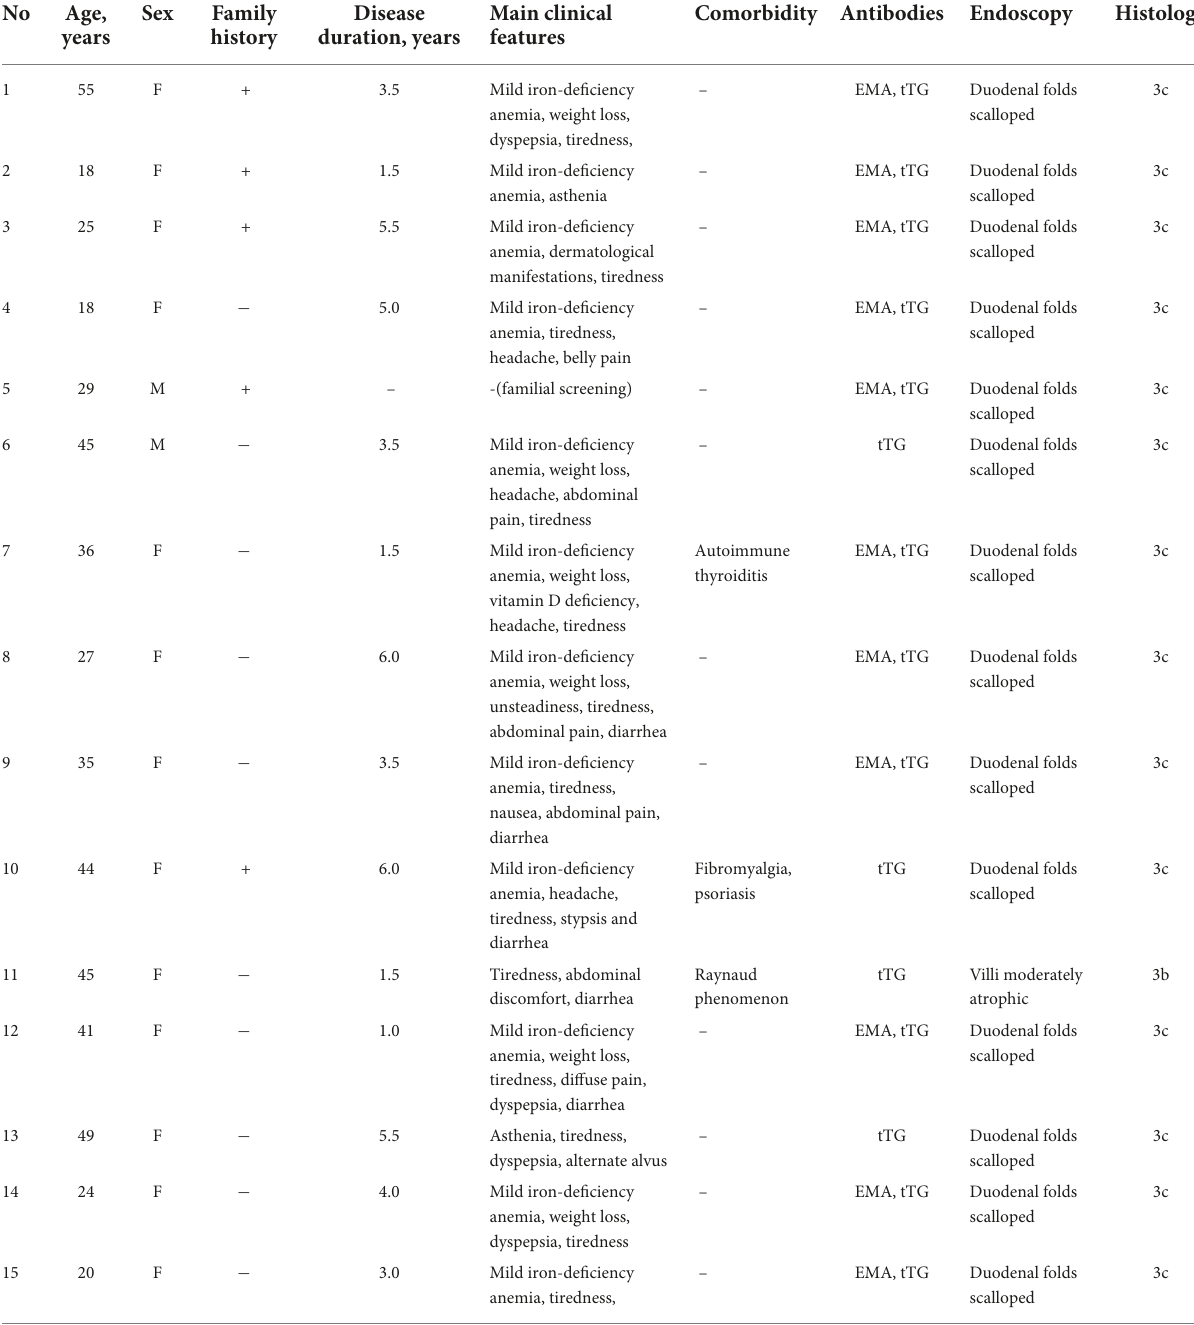
TABLE 1 Relevant laboratory and clinical-instrumental data of subjects with celiac disease. No Age,